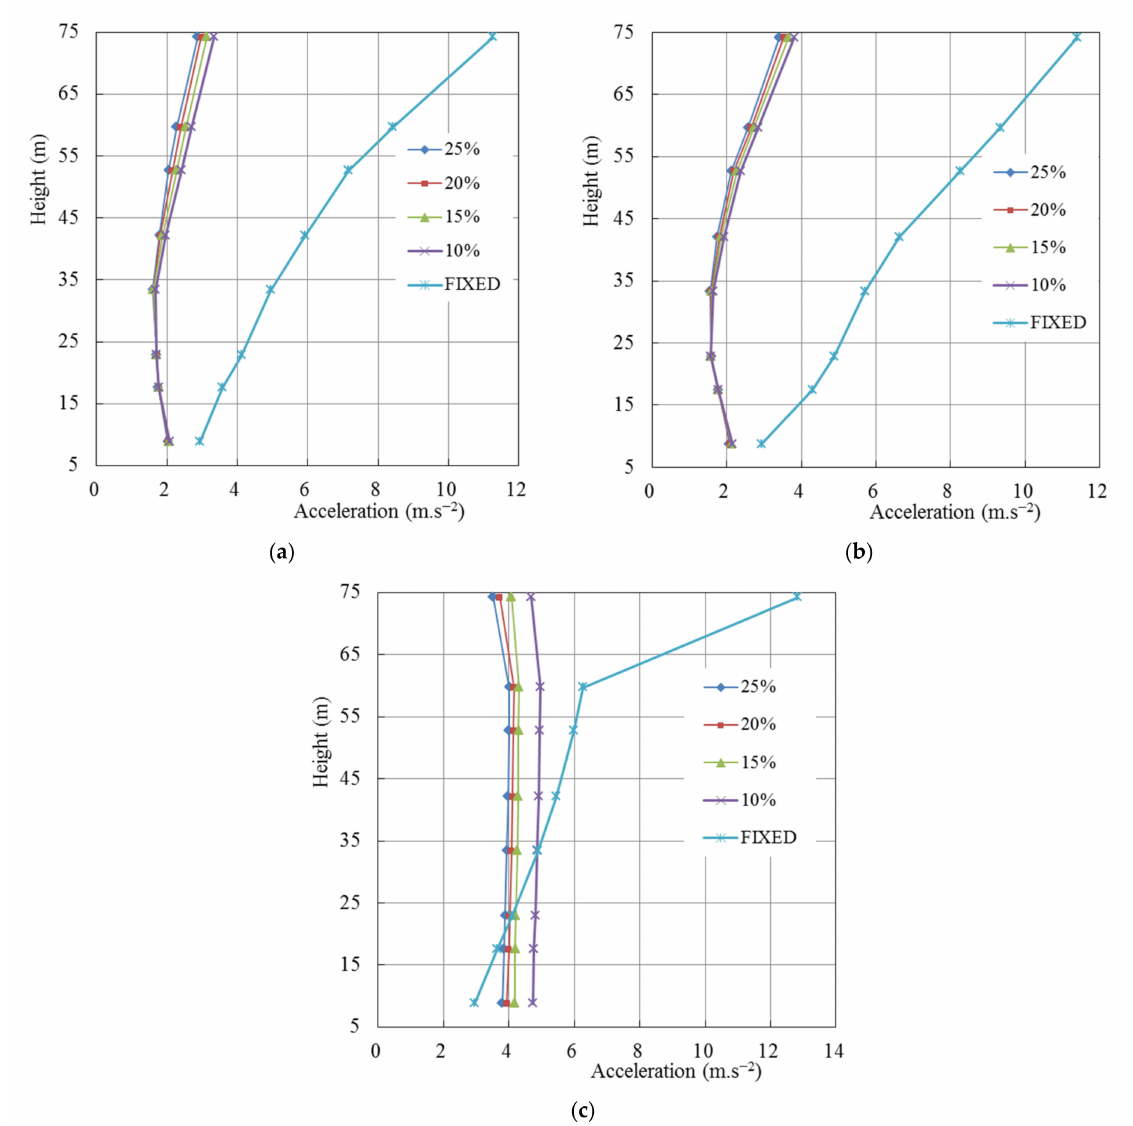
Figure 11. Comparison of the peak acceleration response of the containment. ( a ) In the horizontal direction X ; ( b ) In the horizontal direction Y ; ( c ) In the vertical direction Z